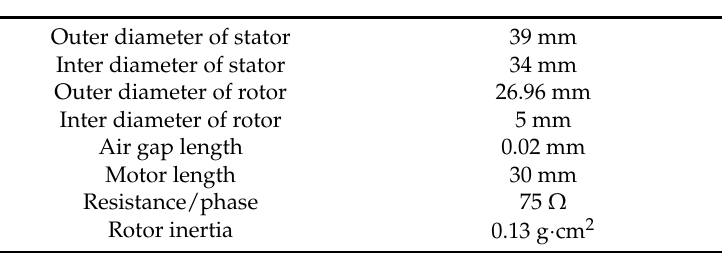
Figure 2. The motor phase windings and the unipolar drive circuit. Table 1. Motor parameters.